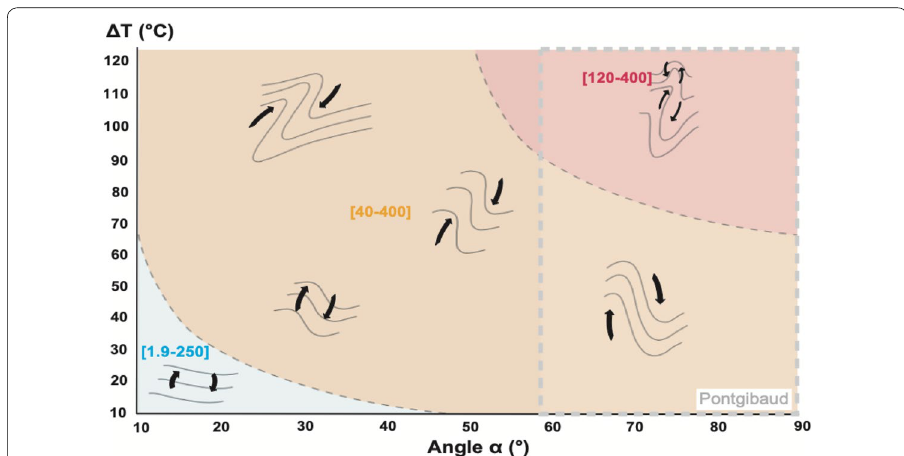
Fig. 12 Diagram of convective regimes. Grey lines represent isotherm morphology. The dashed black line separate three area. In blue, the area of unicellular weak type convection zone. In orange, the area of unicellular medium‑type convection zone. In red, the area of bicellular strong‑type convection zone. The dashed grey contour on the right of the diagram illustrates the possible range for the Pontgibaud fault